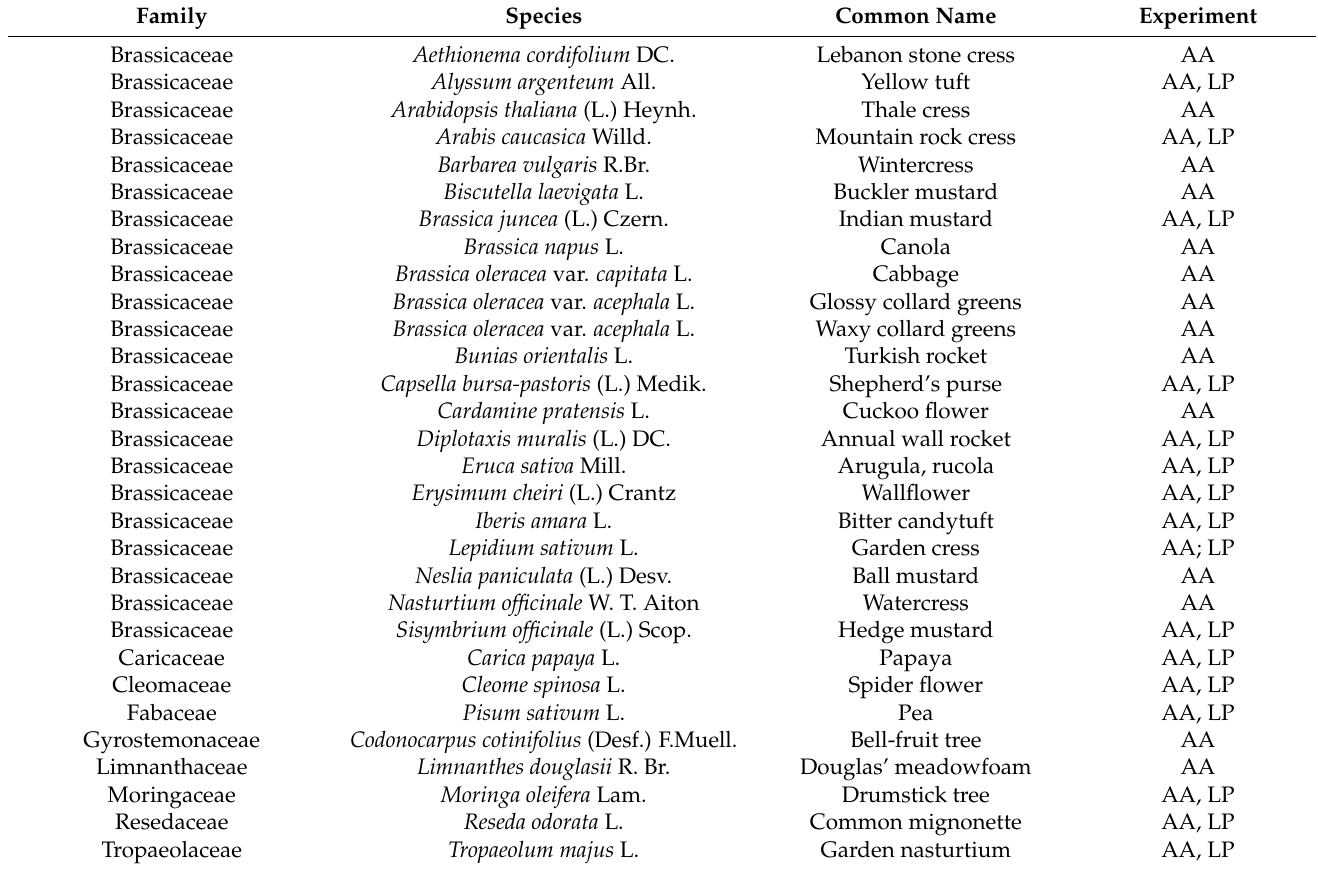
Table 1. Plants used in the different experiments conducted to determine abaxial vs. adaxial oviposition preference (AA) and larval preference